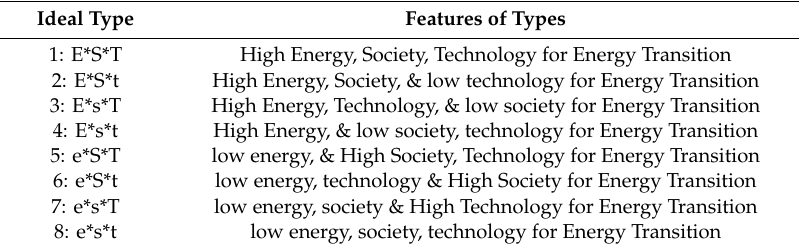
Table 2. The eight ideal type sets.